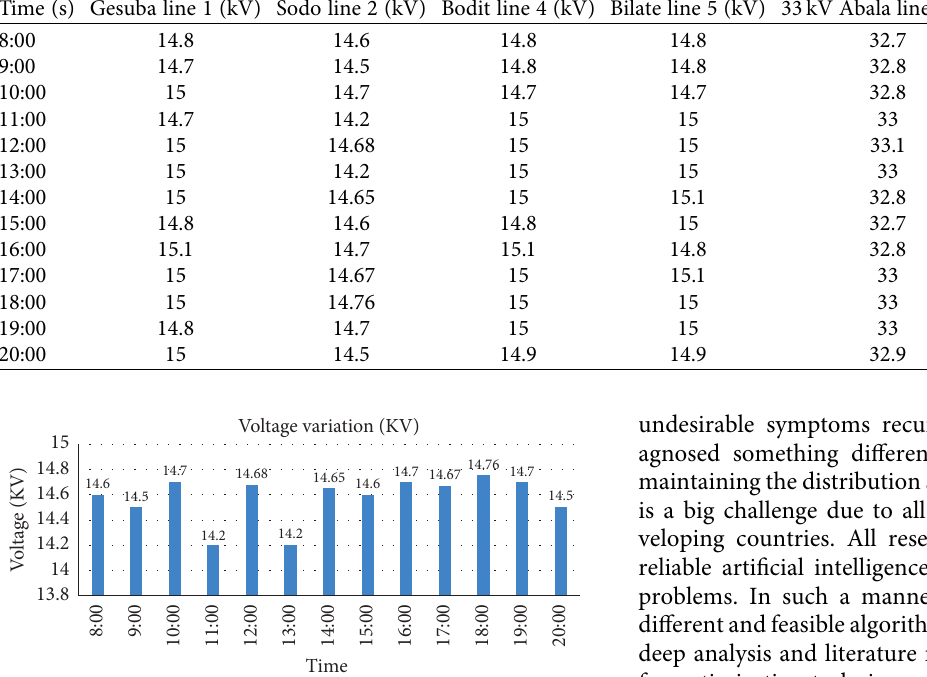
Figure 1: Voltage variation for Sodo line 2 from the substation control